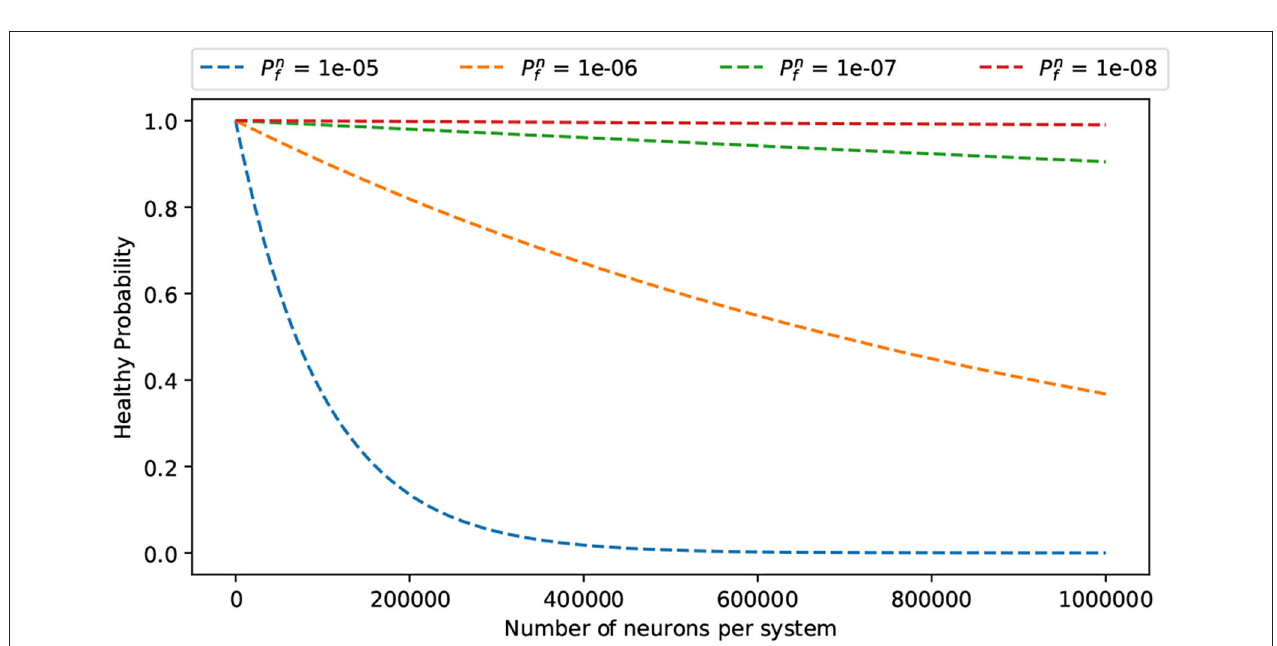
FIGURE 9 | Crossover and mutation method for GA mapping. (A) Crossover. (B) Mutation.